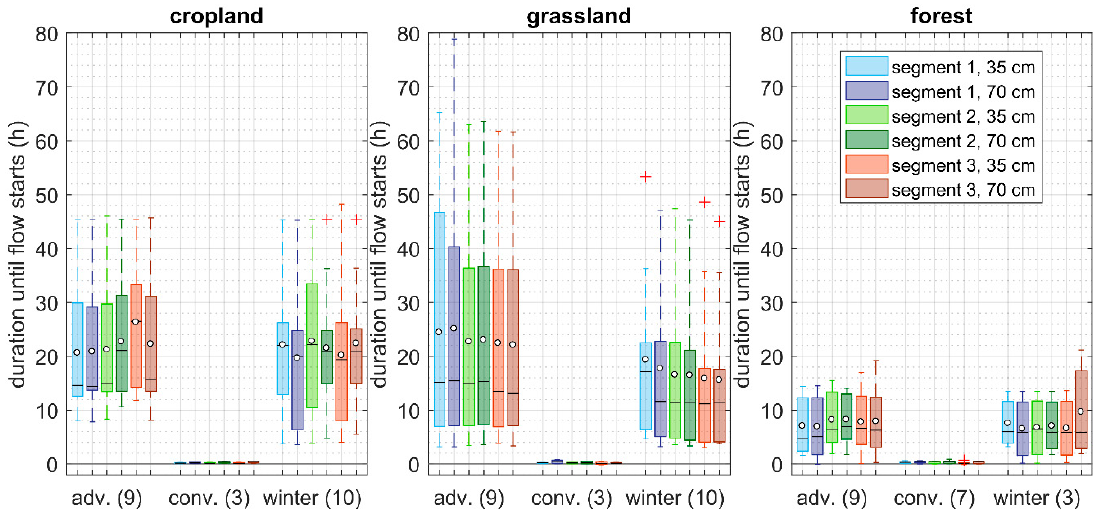
Figure 12. Horizontal and vertical heterogeneity of subsurface flow response times depending on land use, season and precipitation characteristics (adv: advective summer events, conv: convective summer events, winter: winter events; line: median, dot: mean, number of events: brackets).